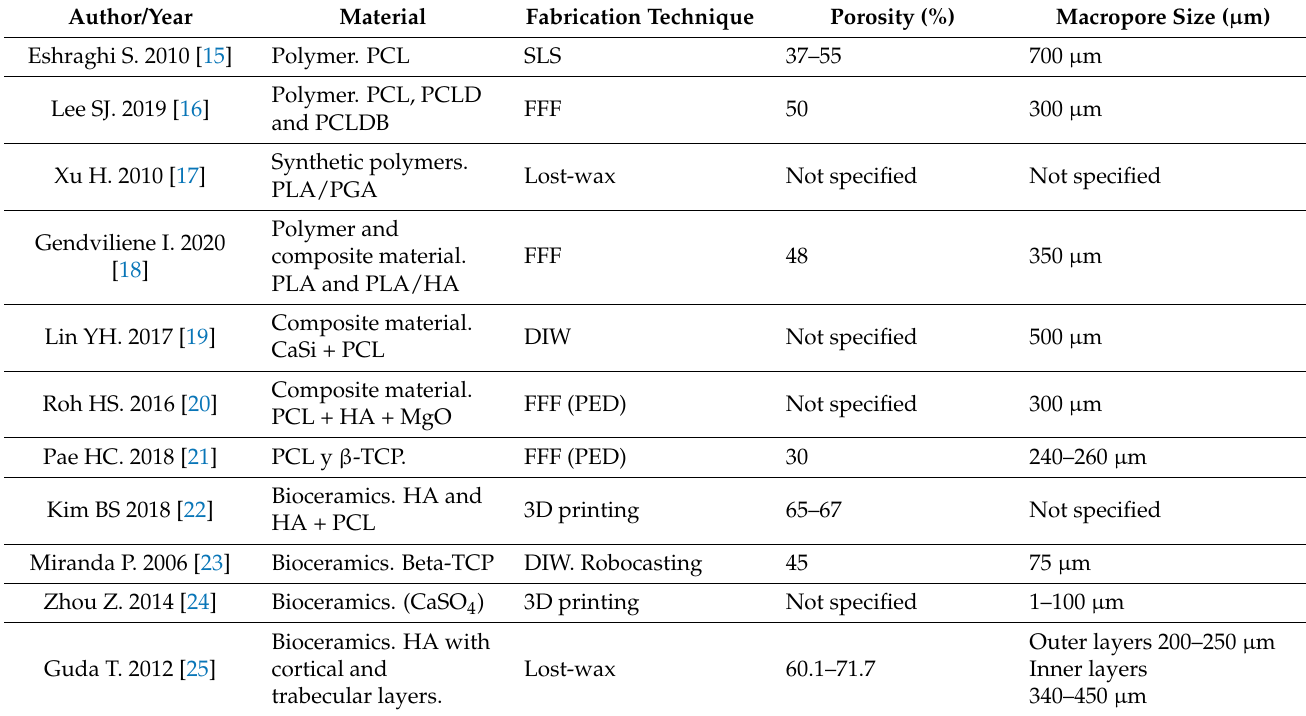
Table 3. Summary of the average porosity and macropore sizes reported in the studies described in Tables 1 and 2.